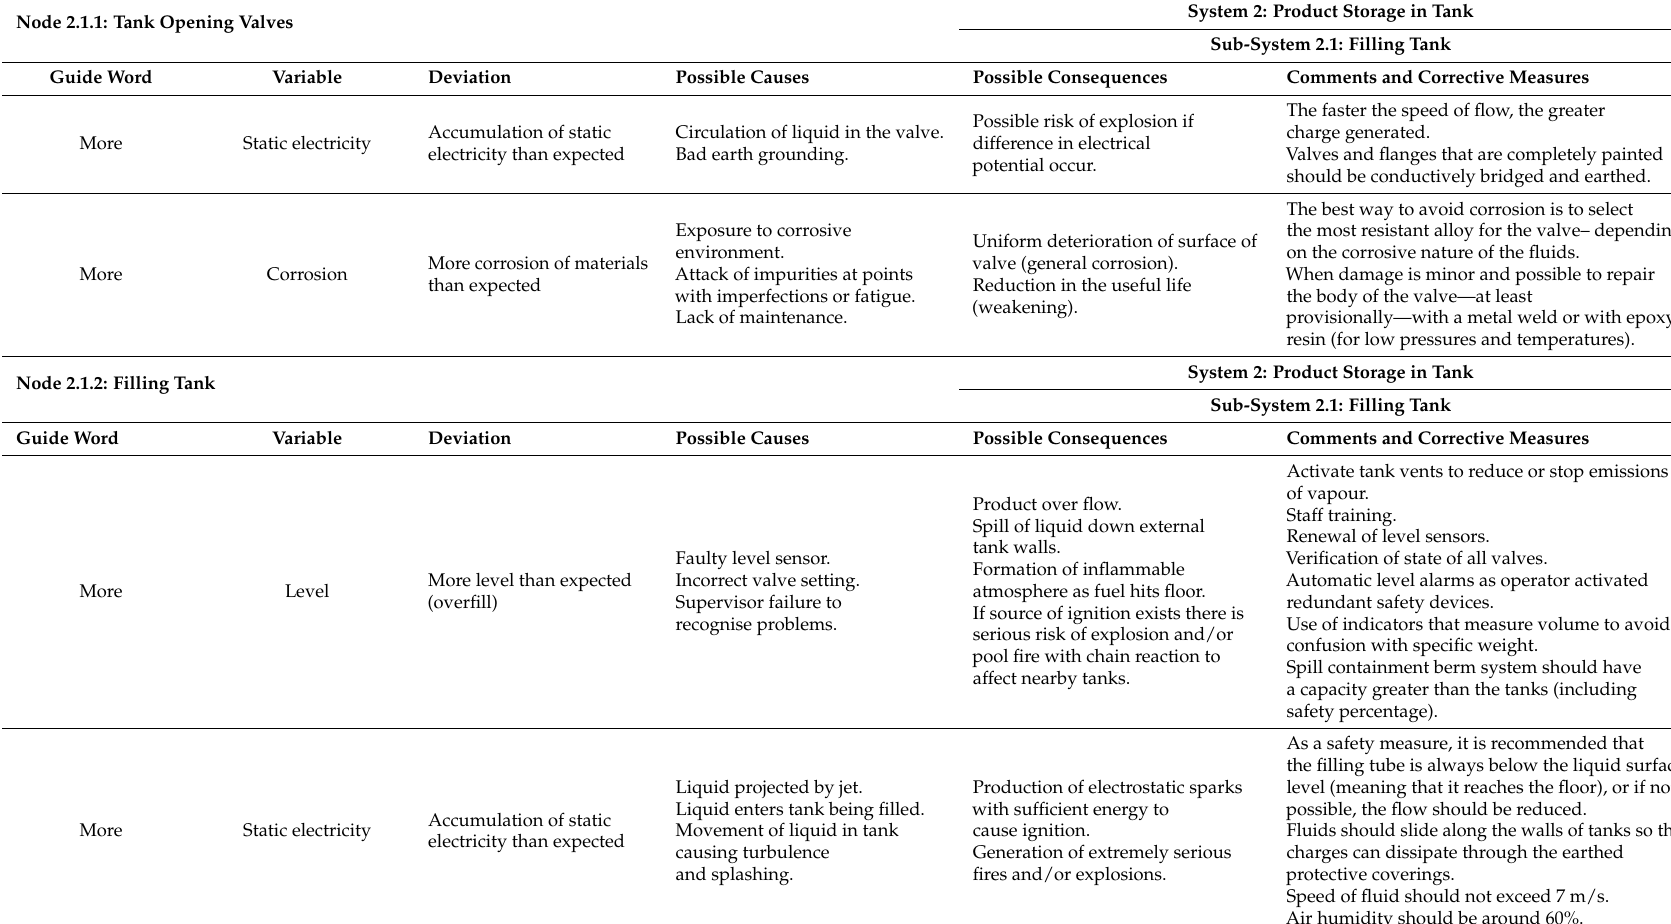
Table 5. Example of HAZOP analysis for nodes 2.1.1 and